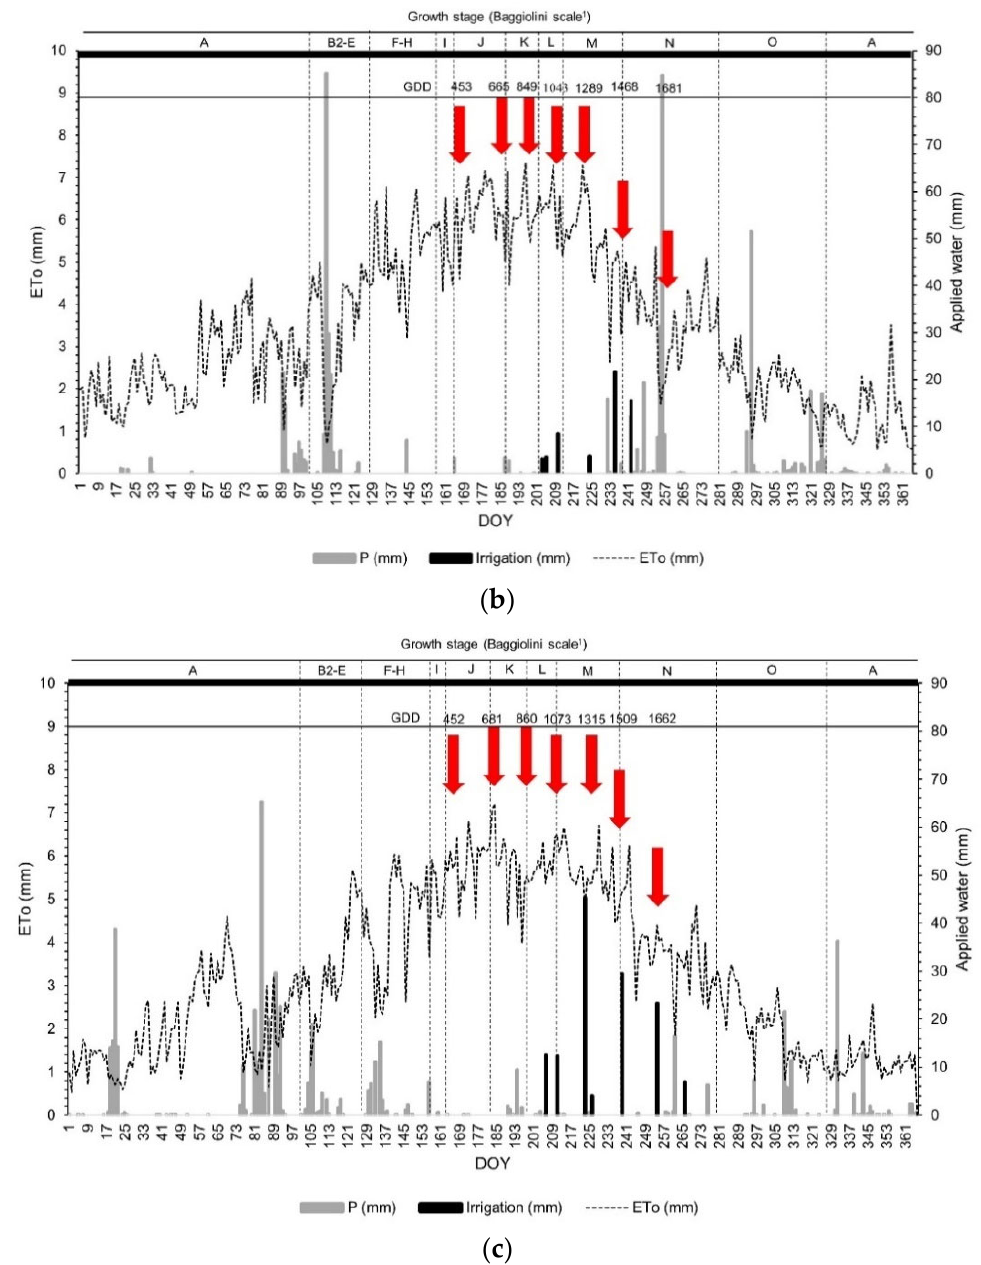
Figure 3. Rainfall (P), irrigation, reference evapotranspiration (ET 0 ), and growing degree days (GDD) during the days of the year (DOY) of the growing cycle in a vineyard located in Fuente- Álamo, Spain, in ( a ) 2018; ( b ) 2019; and ( c ) 2020. The red arrow represents the date of imagery acquisition and Ψ stem measurement. 1 Baggiolini scale: [33] (A: winter dormancy, B: bleeding, B2: bud swelling, C: bud burst, D: green shoot, E: 2 to 3 leaves unfolded, F: inflorescence clearly visible, G: separate inflorescences, H: separate floral button, I: flowering, J: fruit set, K: pea-sized berry, L: closed bunch, M: veraison, N: berry ripening, O: leaf fall).